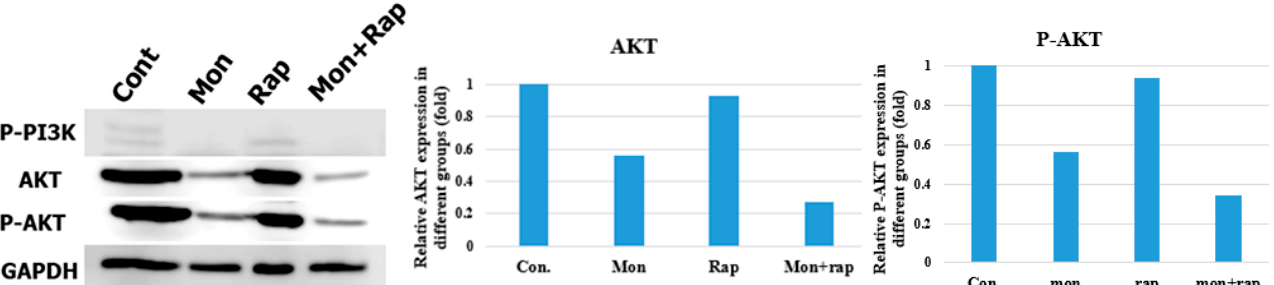
Figure 6. The effects of single and combined mon and rap on the PI3K/AKT pathway. Western blot assays were used to measure the expression of p-PI3K, AKT, and P-AKT in SH-SY5Y cells. Quantification of AKT and P-AKT proteins was performed and normalized to the GAPDH loading control.